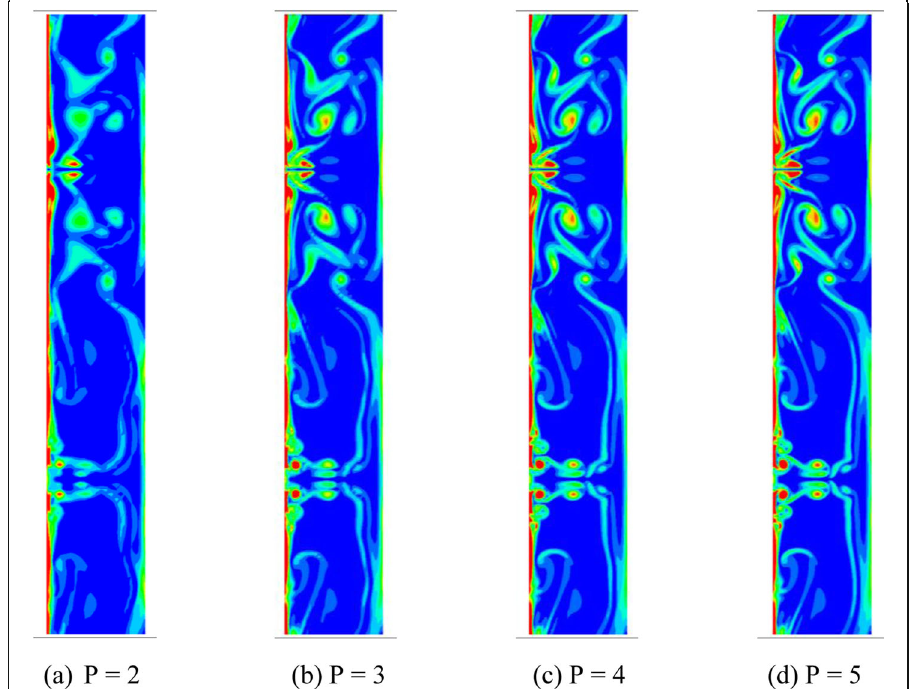
Fig. 6 The vorticity distributions at t 2 computed with different